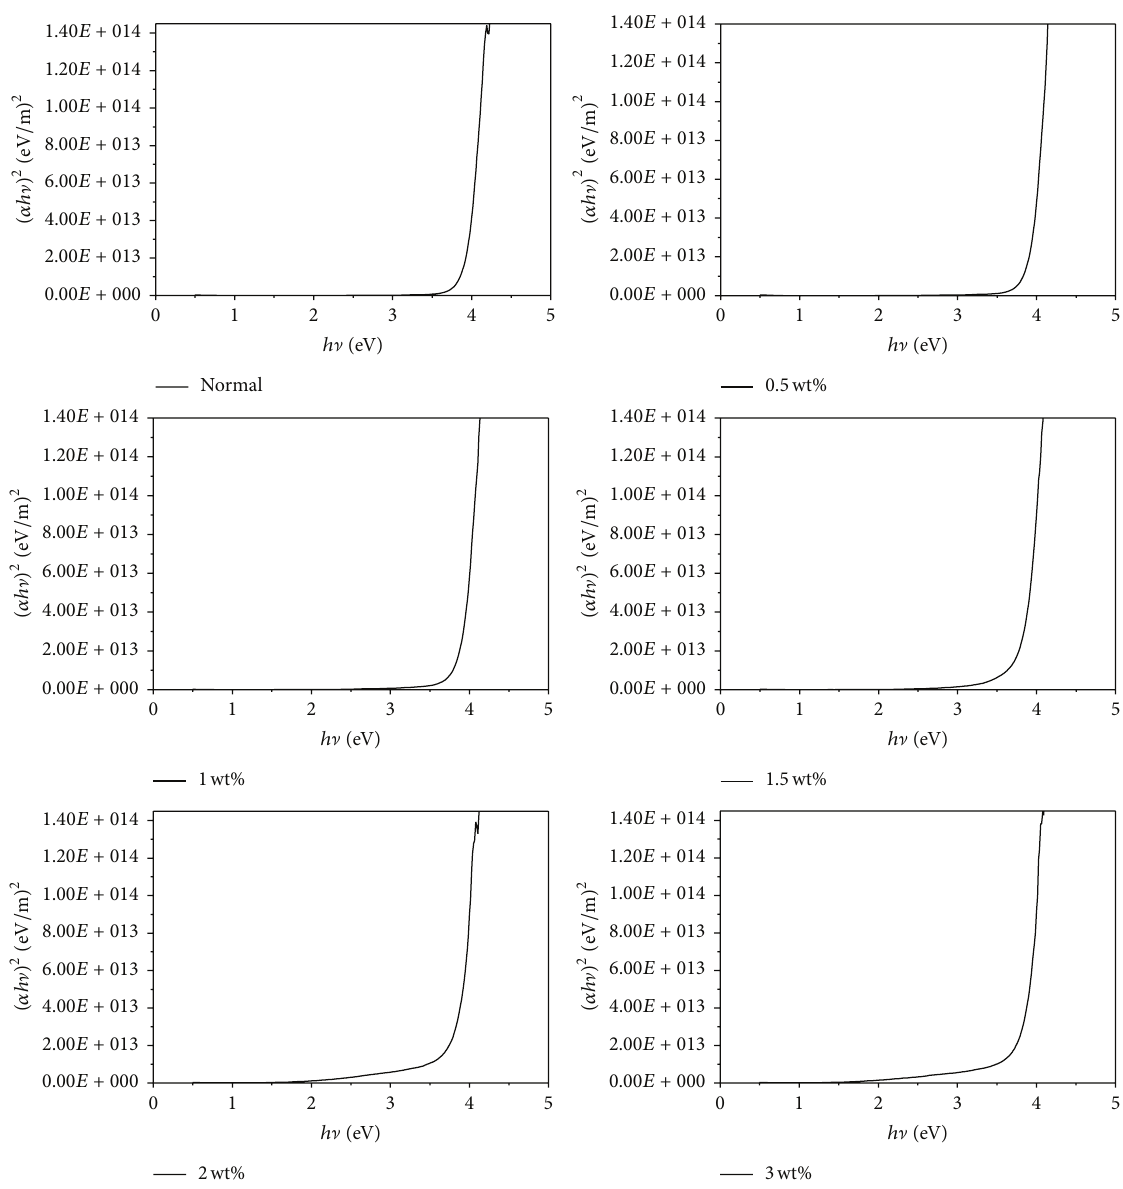
Figure 5: Band gap of TiO 2 thin films with different wt% of carbon black.